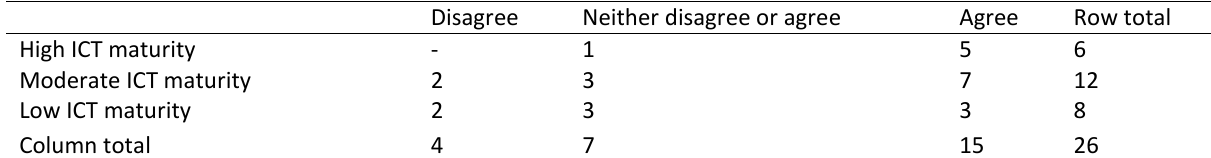
Table 6. Social media use as a good way to market the armed forces and its mission in the area of deployment related to ICT maturity.